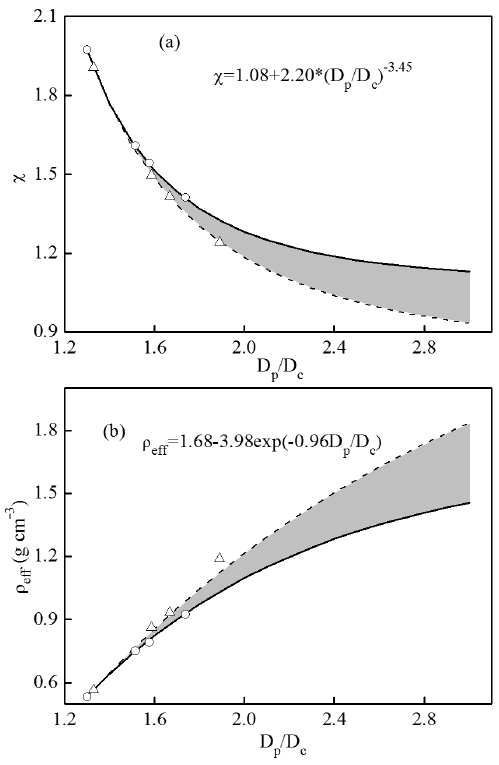
Figure 3. Changes in χ (a) and ρ eff (b) of In-BC cores undergoing aging. The solid lines are fitted based on the data (circle markers) calculated by the measured peak values for size-resolved In-BC par- ticles shown in Fig. 2; the dashed lines are fitted based on the data (triangle markers) derived from a 5% non-volatile coating fraction; the grey shaded area represents the uncertainty in the morphology and density of the In-BC cores obtained